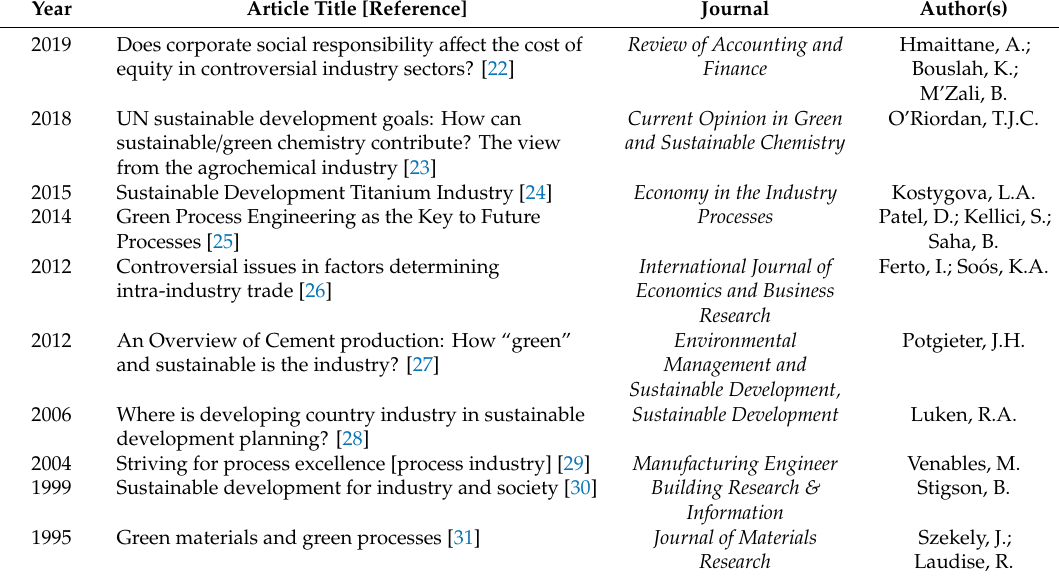
Table 1. Main articles reviewed in relation to the objective of the research